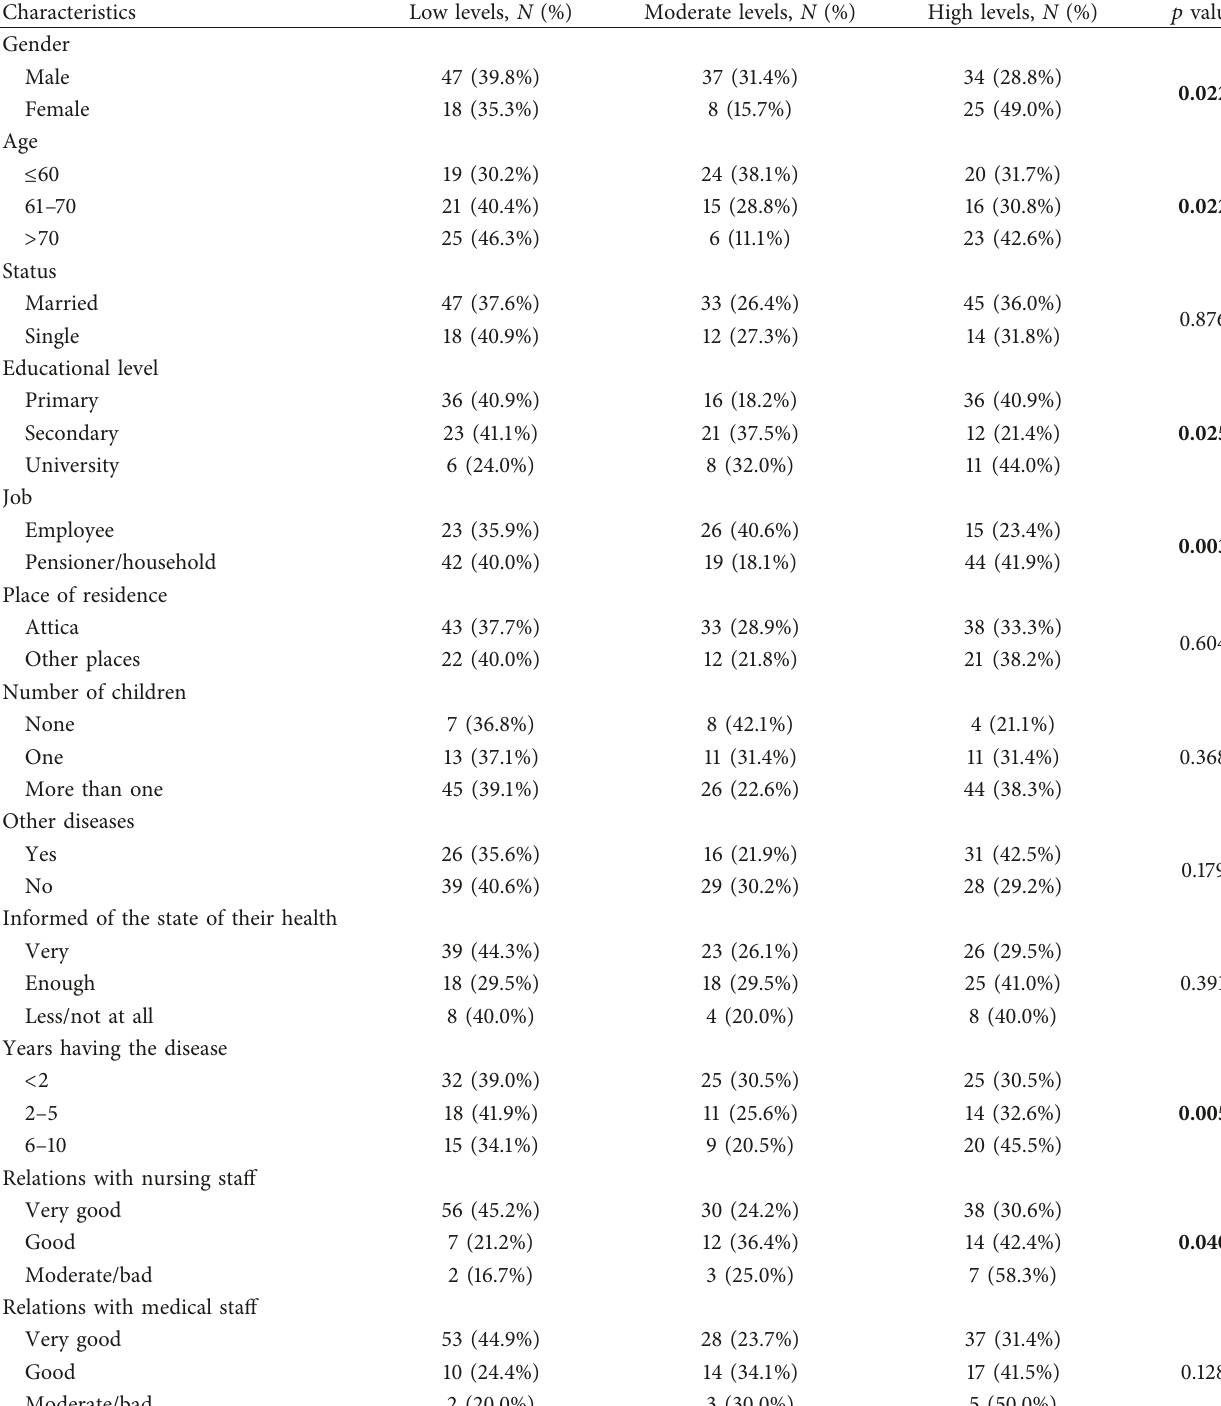
Table 3: Association between patients’ characteristics and anxiety